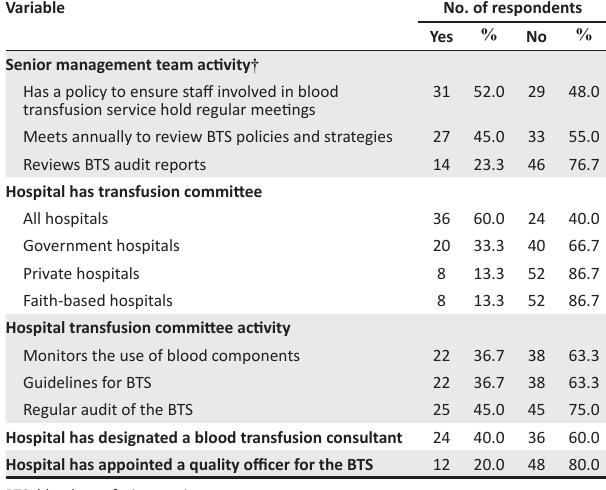
TABLE 2: Participants’ responses on extent of implementation of organisation management, in hospitals of Nairobi County,